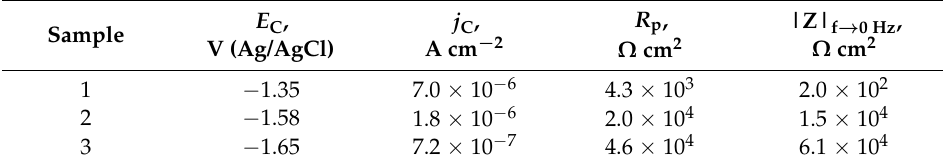
Figure 11. Potentiodynamic polarization curves obtained in 0.9% NaCl for: 1—bare Mg alloy; 2—CaP coated Mg (350 V, 10 min); 3—CaP coated Mg (450 V, 10 min). Table 1. Electrochemical parameters of the